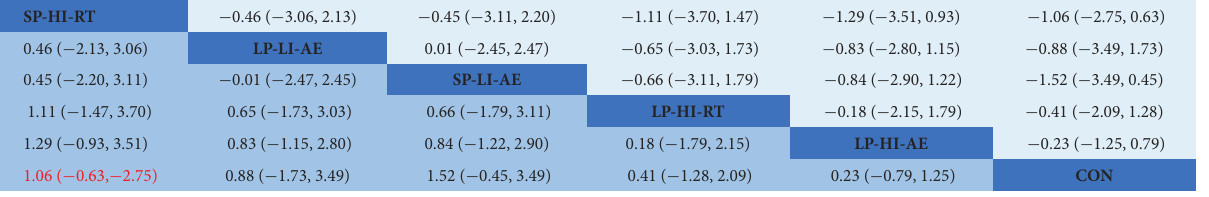
TABLE 5D Network meta-analysis of the efficacy of 6MWT.